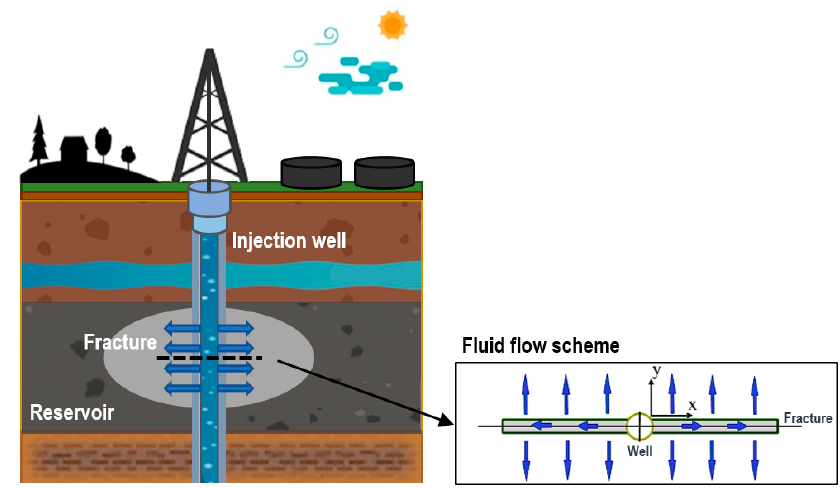
Figure 1. Fluid-flow scheme: from well to fracture and from fracture to reservoir. Due to symmetry, one wing of the fracture is considered. The axis Ox will be along the direction of the fracture, and the origin of the coordinates, x = 0, is placed on the borehole wall. The axis Oy is directed perpendicular to the plane of the fracture, and counted from the fracture wall (Figure 1).